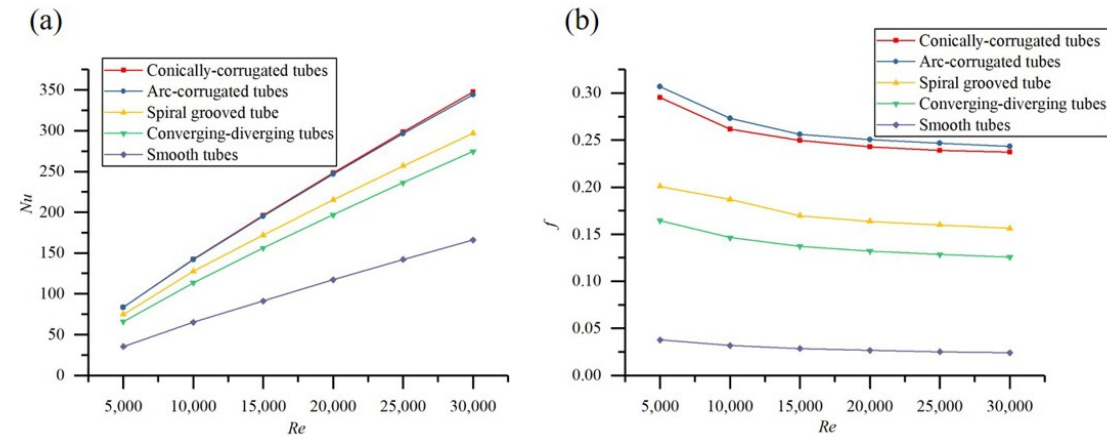
11 of 14 Figure 11. The local heat transfer coefficient plotted at each plane at Re = 10,000 for HEHE tubes. 4.7. Effects of Reynolds Number on the Heat Transfer and Flow Resistance Figure 12a shows the variation in the Nu with Reynolds number for the studied tubes. It is clear that the Nu increased with the increase in the Reynolds number, and that